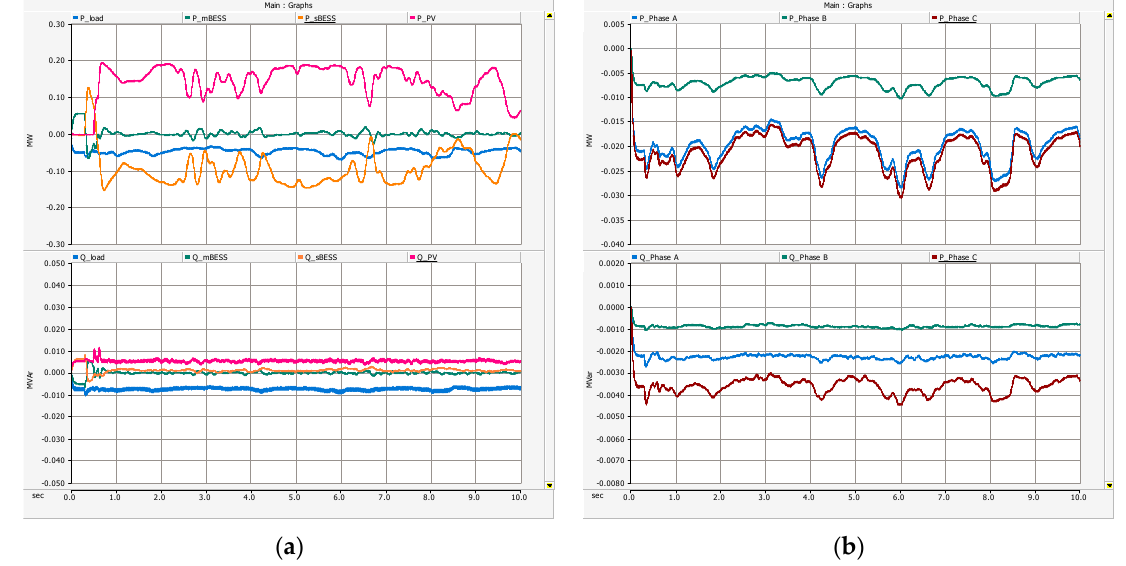
Figure 12. Simulation results of Scenario 1 ( a ) Whole power system (top: active power; bottom: reactive power) and ( b ) load demand (top: active power for each phase; bottom: reactive power for each phase).